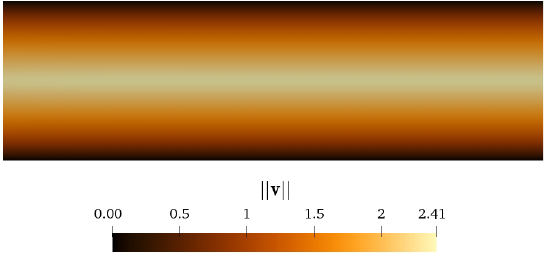
Figure 9. Contour plot of the velocity profile for the 2D channel flow with U = 1.5133. Parameter values are: